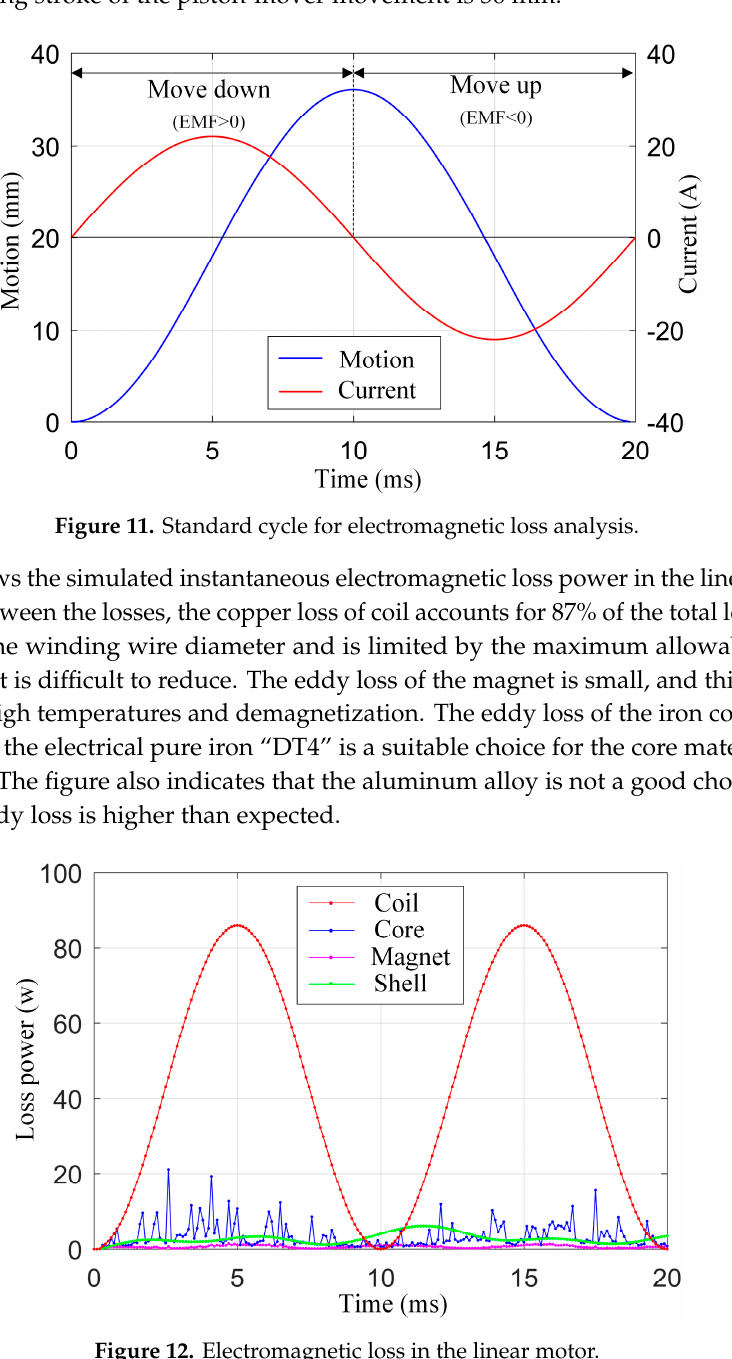
Figure 12. Electromagnetic loss in the linear motor.